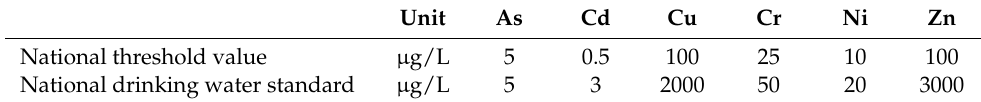
Table 1. Drinking water quality standard and groundwater threshold values in Denmark.